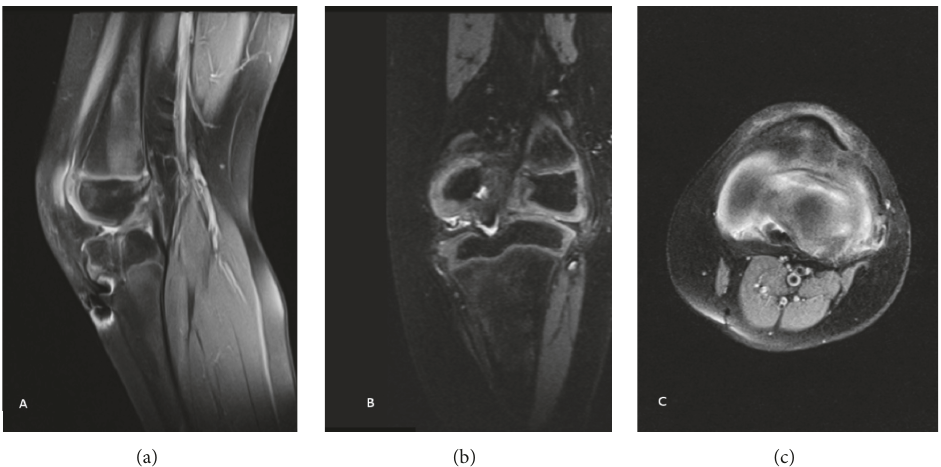
Figure 5: Postoperative MRI (sagittal (a), coronal (b), and transverse (c) views) of the right knee of the patient from Figures 1–4. Graft integrity was inconclusive.